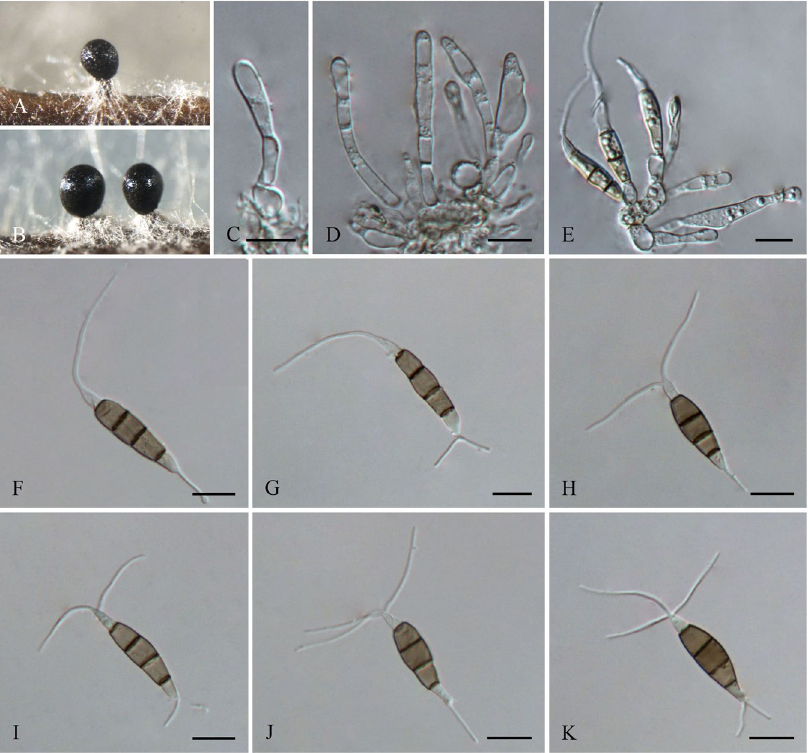
Figure 10. Pestalotiopsis jinchanghensis (from ex-holotype culture CGMCC 3.18158 ( = LC6636)). ( A